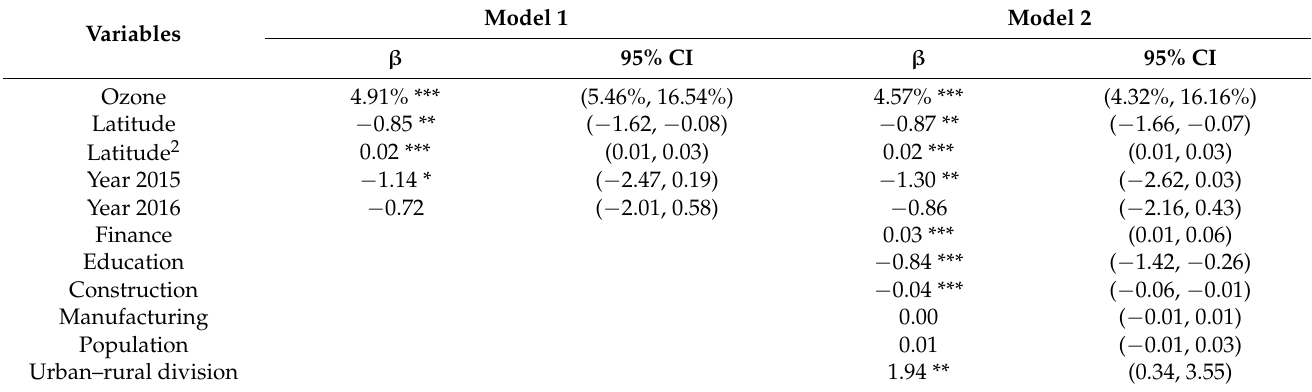
Table 2. Ozone and the incidence rate of female lung cancer: associations in the two models.